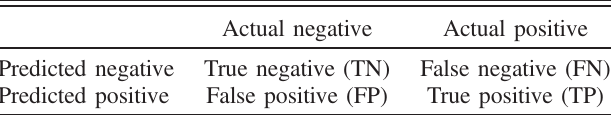
TABLE II. Confusion